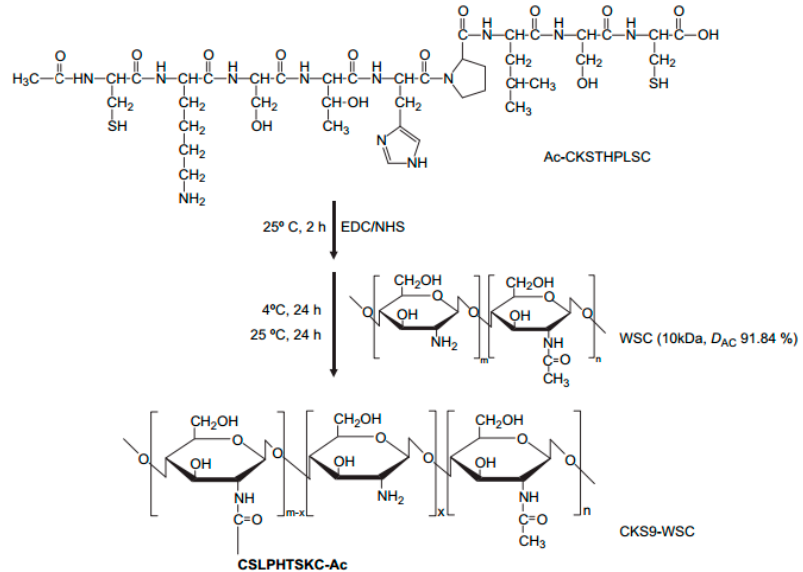
Figure 11. Proposed reaction scheme for synthesis of CKS9-conjugated water-soluble chitosan (CKS9-WSC). CKS9 peptide was chemically conjugated to water-soluble chitosan through the amide linkage between amino group of WSC and carboxylic group in the C-terminal of the CKS9 peptide using NHS/EDC coupling agents [52].